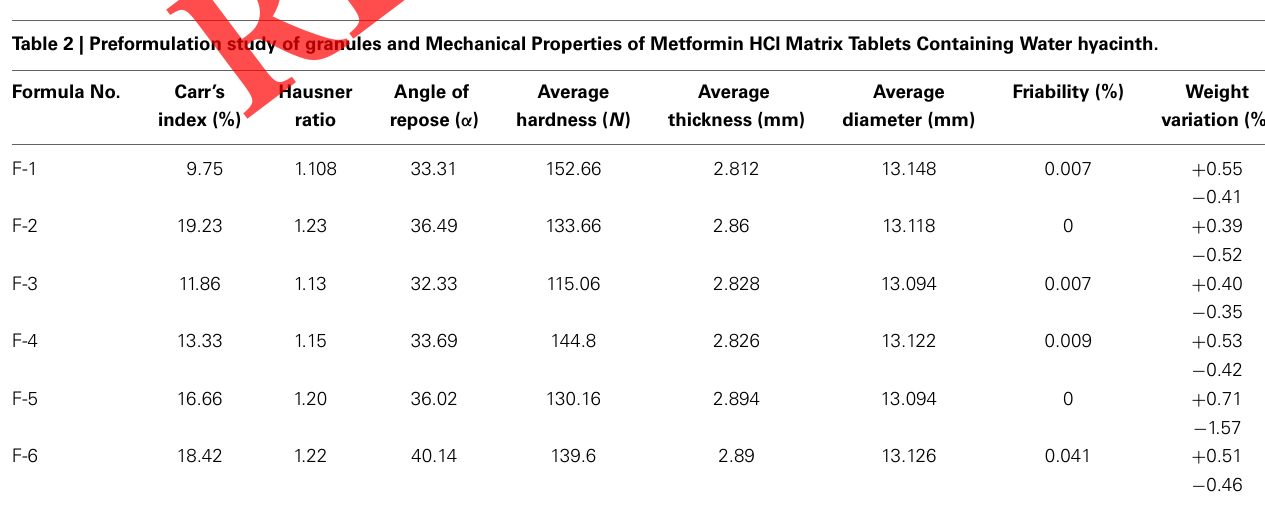
Table 2 | Preformulation study of granules and Mechanical Properties of Metformin HCl Matrix Tablets Containing Water hyacinth. Formula